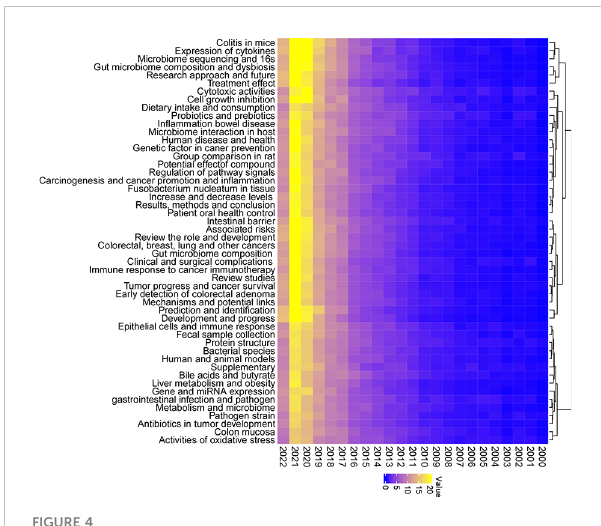
FIGURE 4 Fifty topics identi fi ed by the Latent Dirichlet Allocation (LDA) algorithm in publications of the gut microbiome in the CRC from 2000 to 2022. Blue, low occurrence value; yellow, high occurrence value.